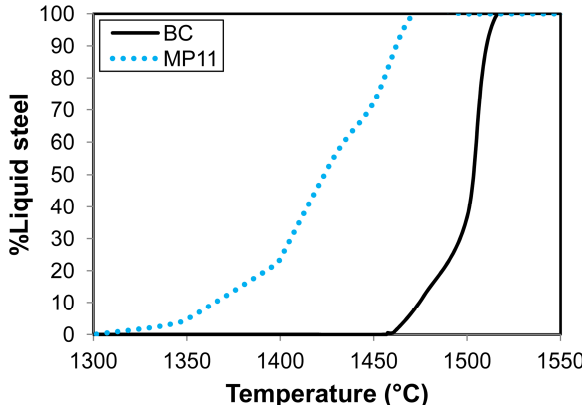
Figure 3. Solidification curves for MP11 and BC weld metal compositions from Table 3 (mass% proportion liquid phase in steel).